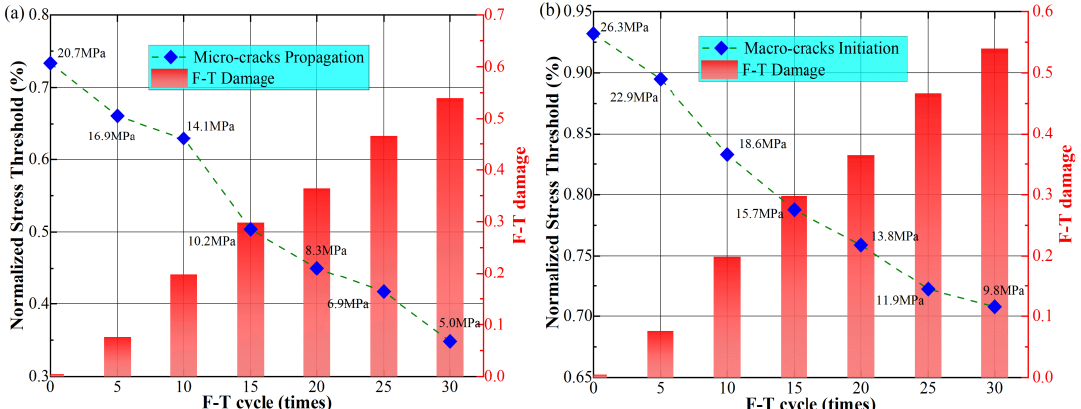
Figure 18. Acoustic behavior of the sandstone that was subjected to different F–T action. ( a ) Micro-cracks; ( b ) Macro-cracks.